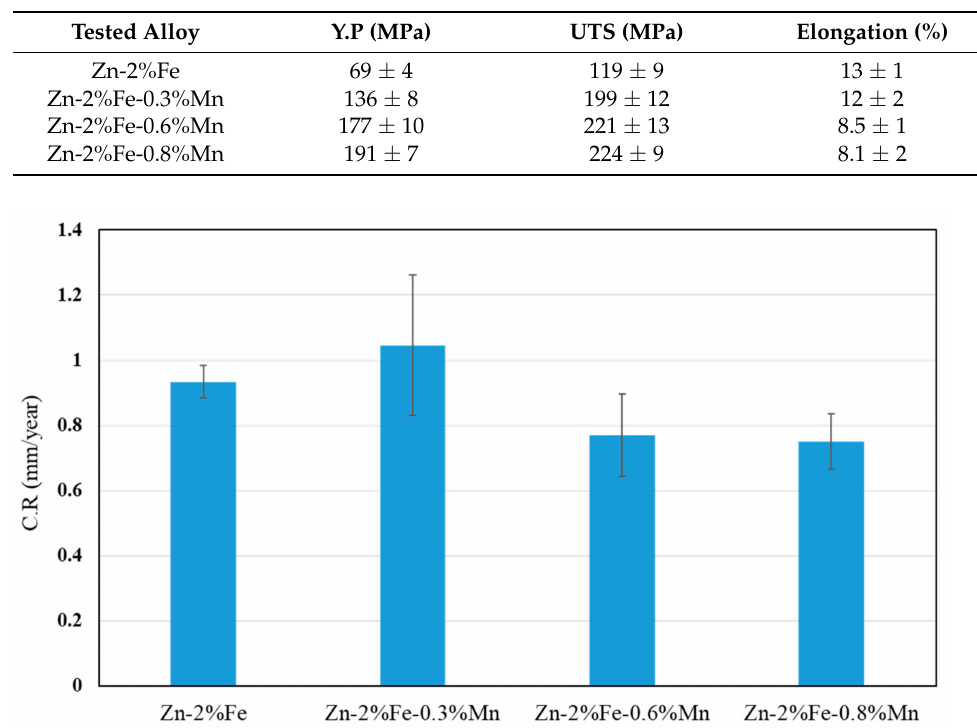
Figure 6. Tyical tensile test analysis results of the tested alloys. Table 3. Mechanical properties derived from tensile tests shown in Figure 7.